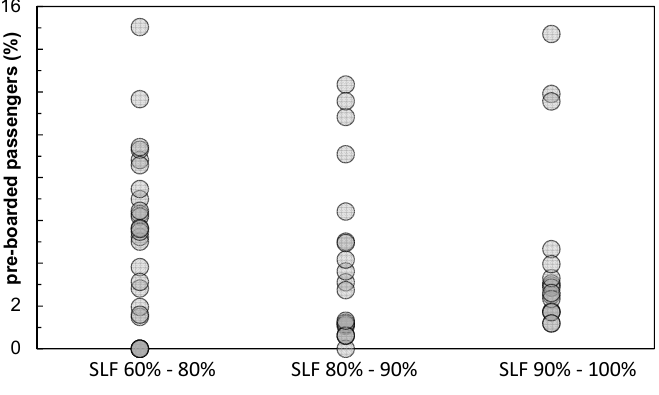
Figure 15. Amount of pre-boarding passengers.